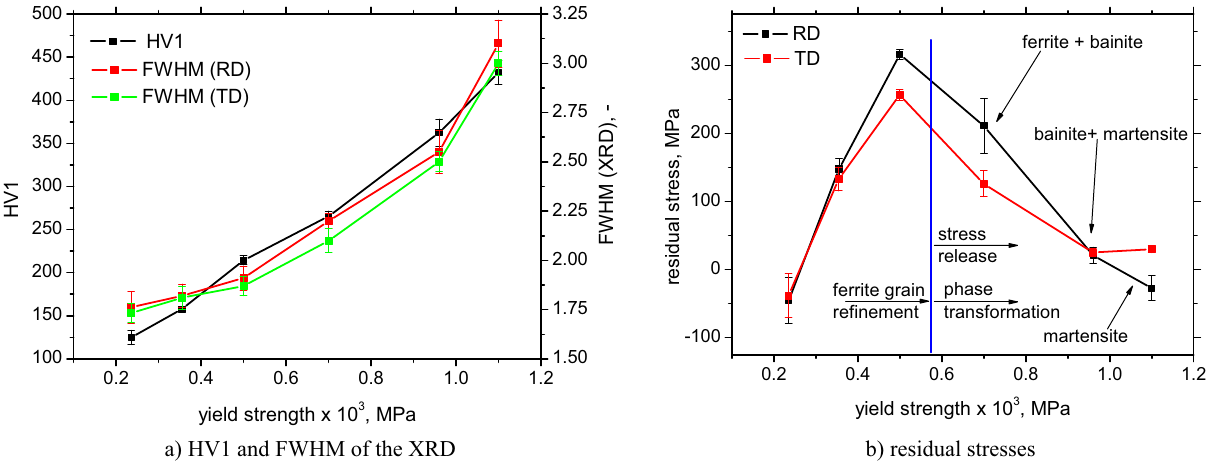
Figure 7. Evolution of HV1 and FWHM of the XRD and residual stresses as a function of the nominal σ YS .